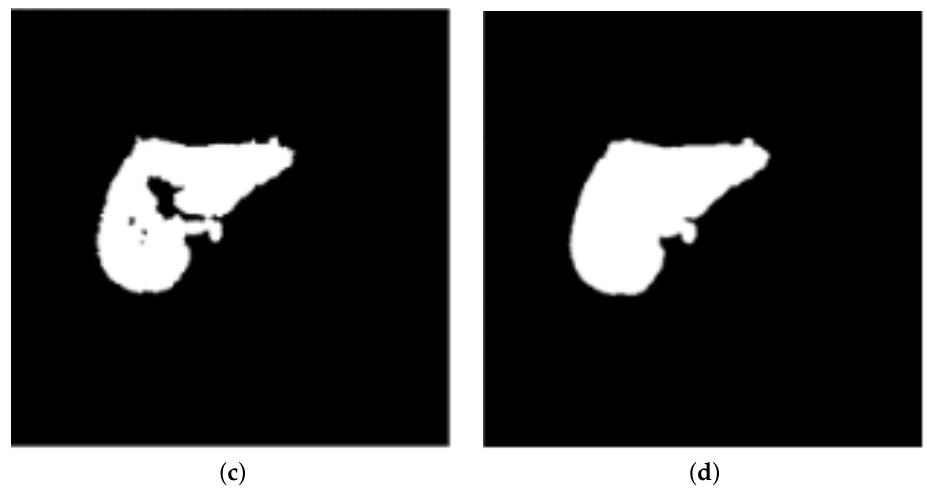
Figure 4. Comparison results of regional growth of the same seed point: ( a ) the seed point selection; ( b ) the regional growth result of the original image without SFCM clustering; ( c ) the regional growth result of the image with SFCM clustering; ( d ) the regional growth result of our